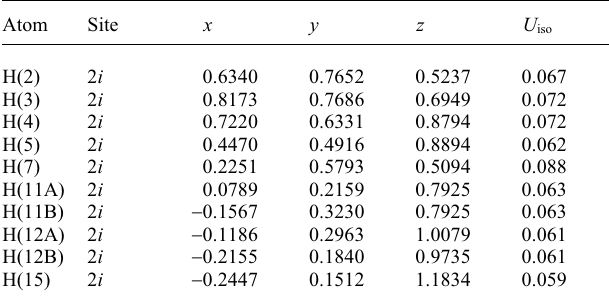
Table 2. Atomic coordinates and displacement parameters (in Å 2 )